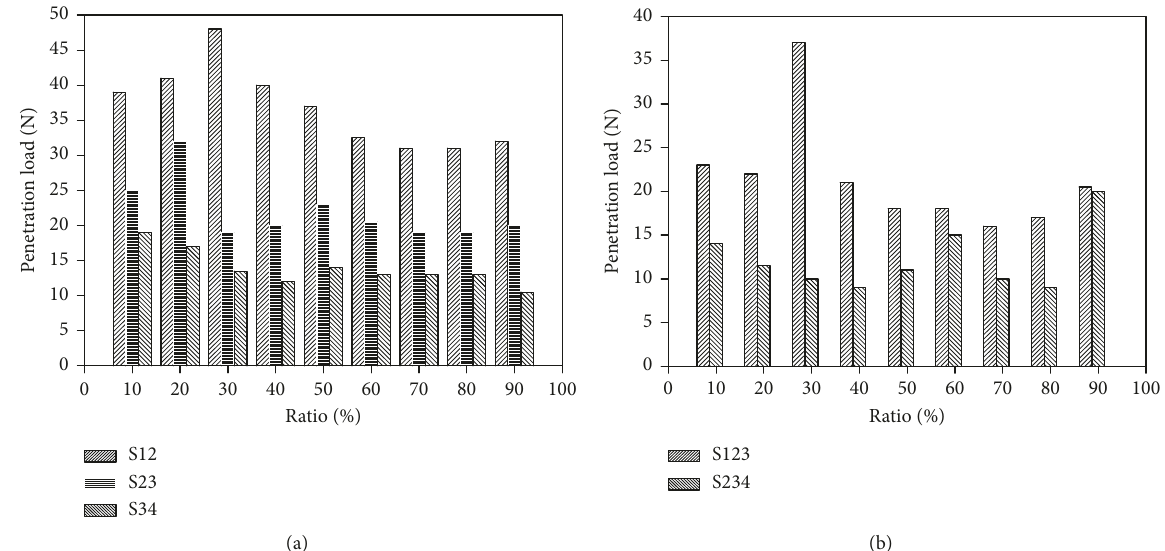
Figure 8: Penetration loads of five kinds of mixtures at the penetration displacement of 6mm (a) two-aggregate mixtures and (b) three- aggregate